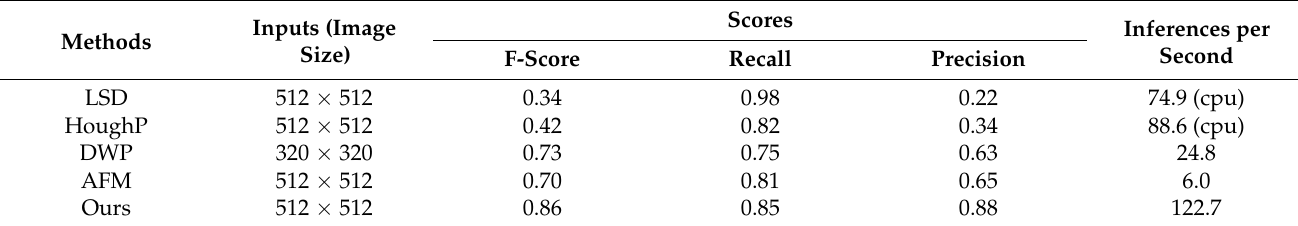
Table 1. Comparison of results between all the